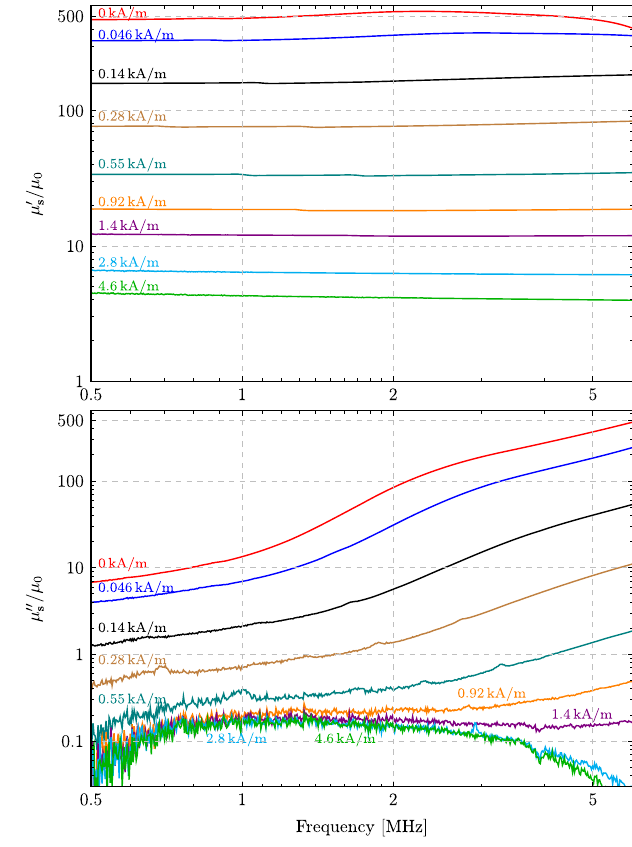
FIG. 8. Real part (above) and imaginary part (below) of the permeability μ as obtained from the reflection measurement s analysis with different bias field strengths as a function of frequency.FIG. 7. Comparisonoftherealpart(above)andtheimaginarypart